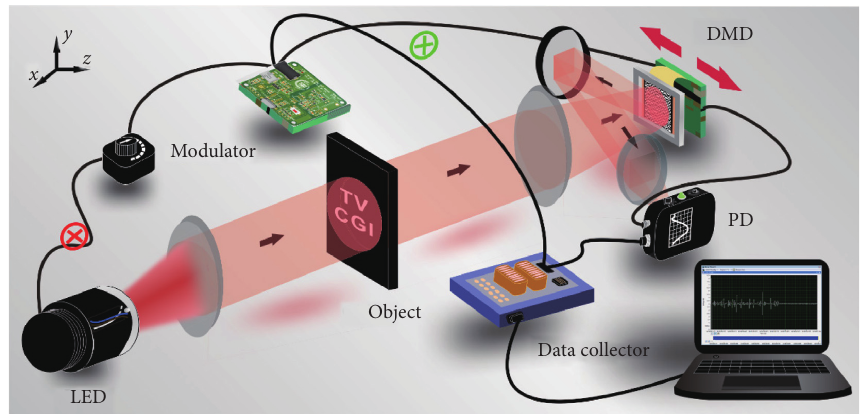
Figure 4: Schematic of the experimental setup of the TV-CGI